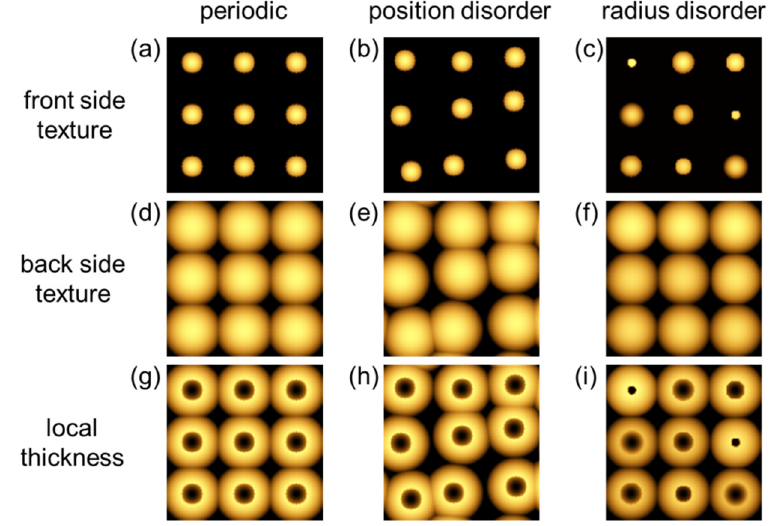
Figure 4. Top view images of the frontside texture ( a–c ), backside texture ( d–f ) , and local layer thickness ( g–i ) for the perfect periodic grating and the gratings with position and radius disorders.